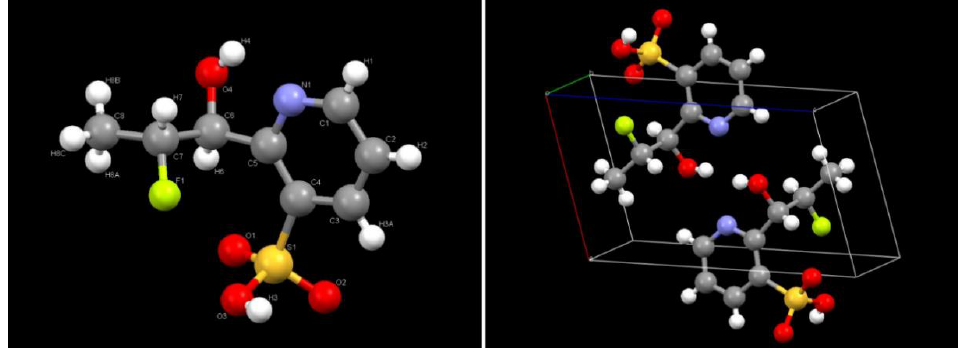
Figure 4. X-ray Crystal structure of product M2 and packing of M2 within a unit crystal cell. The third isolated compound M 3 was eluted with solvent composition, hexane – ethyl acetate (50:50) with a single spot in TLC. Compound M 3 was found at a very low amount. The full scan ESI – MS analysis of M 3 showed a mass spectrum of m/z 415.17 (M 3 + H) and m/z 437.16 (M 3 + Na). The identity of M 3 was not fully confirmed, but the ESI-MS analysis M 3 as an important intermediate N -((4,6-dimethoxypyrimidin-2-yl) amino carbonyl)-2-(1- hydroxy-2-fluoropropyl)-3-pyridine sulfonamide. This particular metabolite is also re- ported to be formed during the in-vitro metabolism of flucetosulfuron in artificial gastro- intestinal juice [29] as well as in rice plant and barnyard grass [33]. The probable formation of this metabolite is also demonstrated during in-vitro metabolism of the same herbicide by human liver microsome [34]. Moreover, artificial gastrointestinal juices caused rapid degradation of flucetosulfuron hindered its translocation to blood during any accidental oral intake [34]. It implies that the possibility of its human toxicity is quite negligible. The fourth isolated compound M 4 was a white solid eluted by solvent mixture hex- ane – ethyl acetate (10:90). Structure elucidation of M 4 was done with the help of infrared (IR) spectroscopy, proton nuclear magnetic resonance (NMR) spectroscopy and mass spectrometry. Full scan ESI-MS analysis of compound M 4 showed the mass spectrum with a base peak at m / z 488. The IR spectrum of compound M 4 showed several absorption bands. The respective probable groups found in the spectrum were,(C=O) stretching fre- quency for carbonyl group (1719.63 cm −1 ); C=O stretching frequency for ester group (1768.78 cm −1 ); S=O stretching frequency for O=S=O (SO 2 ) group (1366.82 cm −1 ); aromatic C=C stretching and N-H deformation frequency for amide (1636.25 cm −1 ); aromatic C=C stretching (1453.86 and 1582.12 cm −1 ) and N-H stretching band for secondary amide (3191.18 cm −1 ). The 1 H NMR spectrum showed the characteristic signals at δ1.37– 1.39 (d, 3H), 3.13 (s, 3H), 3.92 (s, 6H), 4.05 (s, 2H), 5.99 (d, 1H), 6.71 – 6.75 (m, 1H), 7.89 (s, 1H), 8.26 – 8.29 (dd, 1H), 8.76 – 8.77 (dd, 1H), 8.88 – 8.90 (dd, 1H), 10.66 (s, 1H) and 13.26 (s, 1H). This